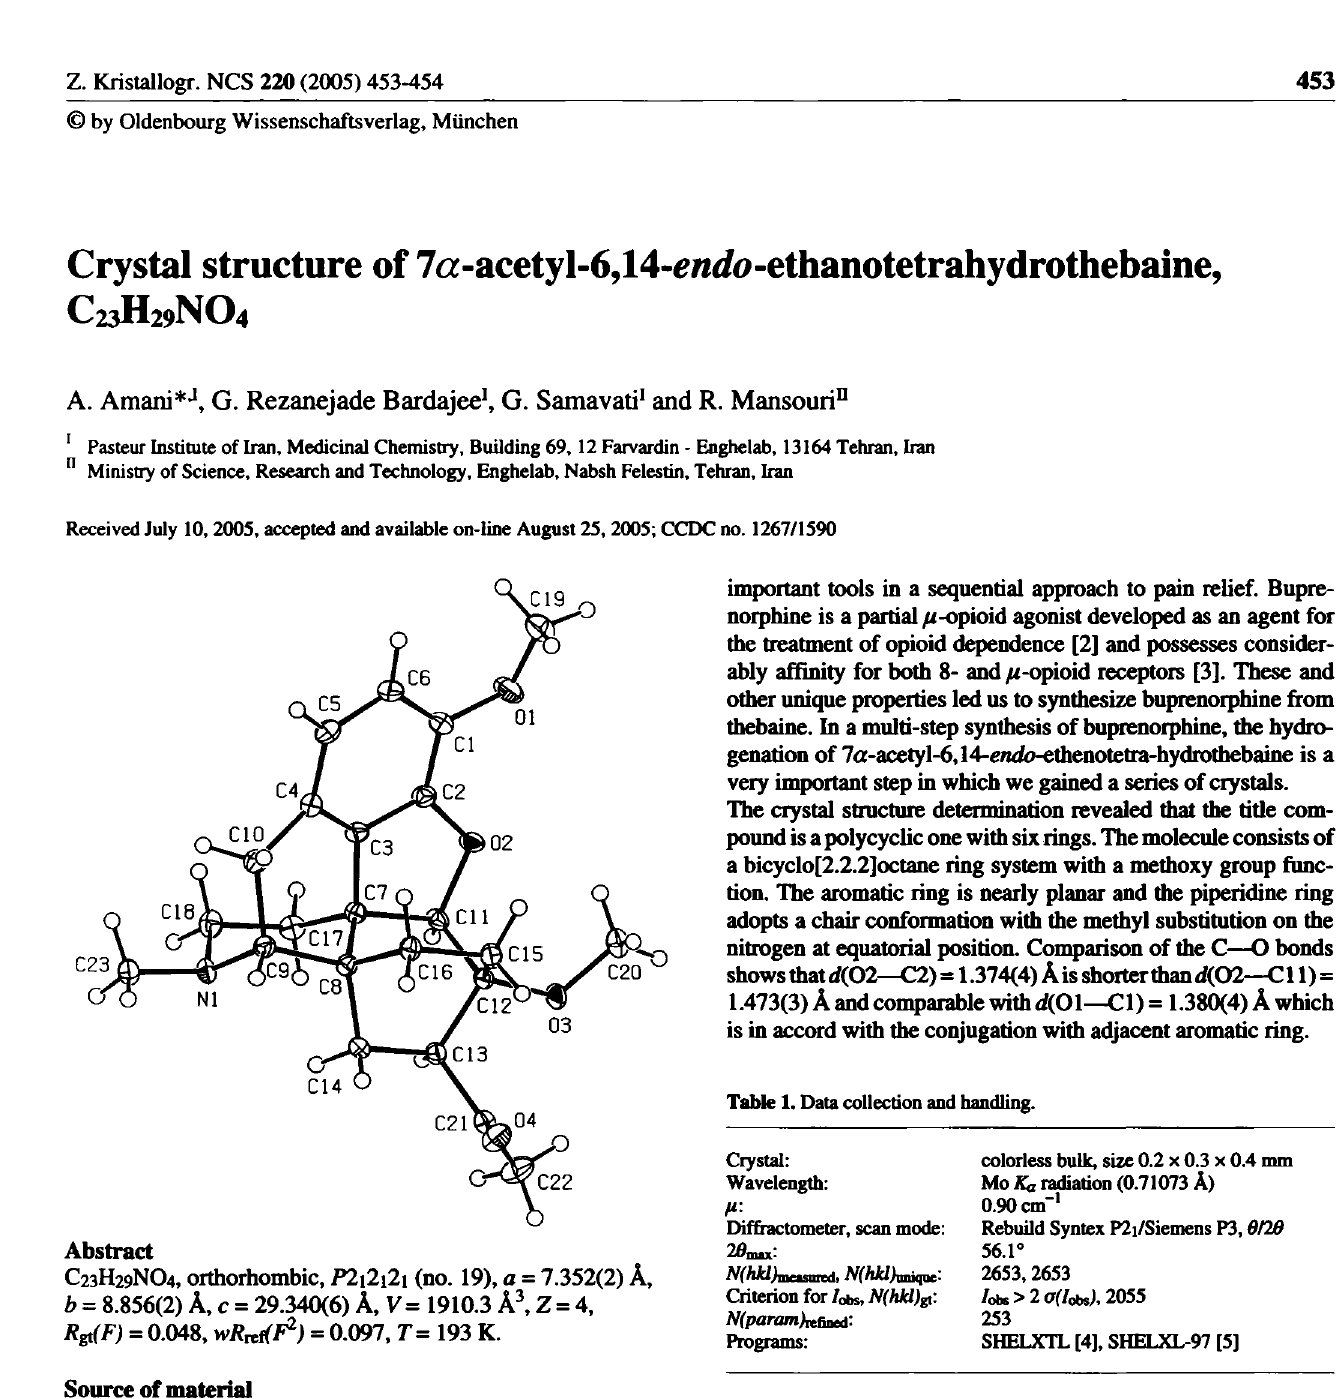
Table 2. Atomic coordinates and displacement parameters (in A 2